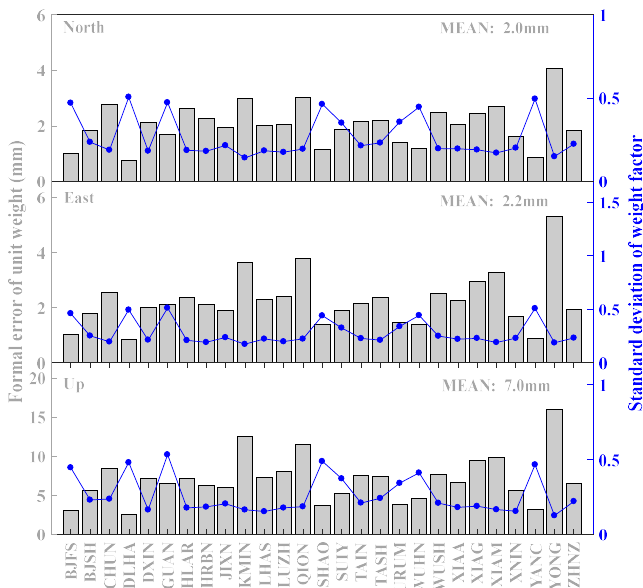
Figure 10. Formal errors of unit weight (grey bar) and standard deviations of weight factors (blue line) for 27 stations.